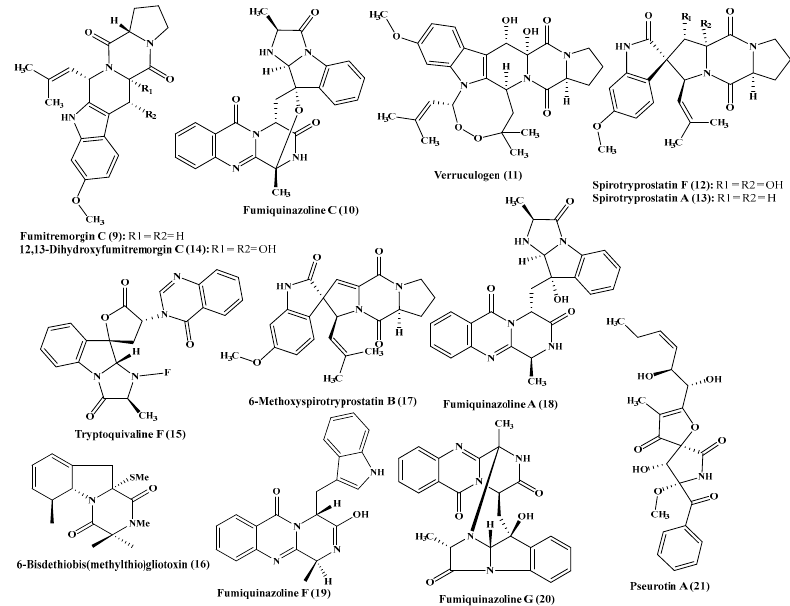
Figure 2. Alkaloids isolated from Aspergillus fumigatus.